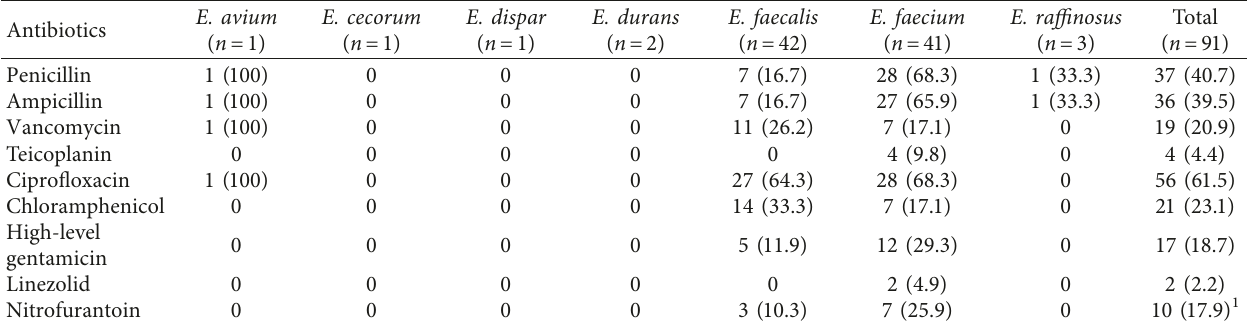
Table 3: Antimicrobial resistance patterns among enterococcal species (N (%)).